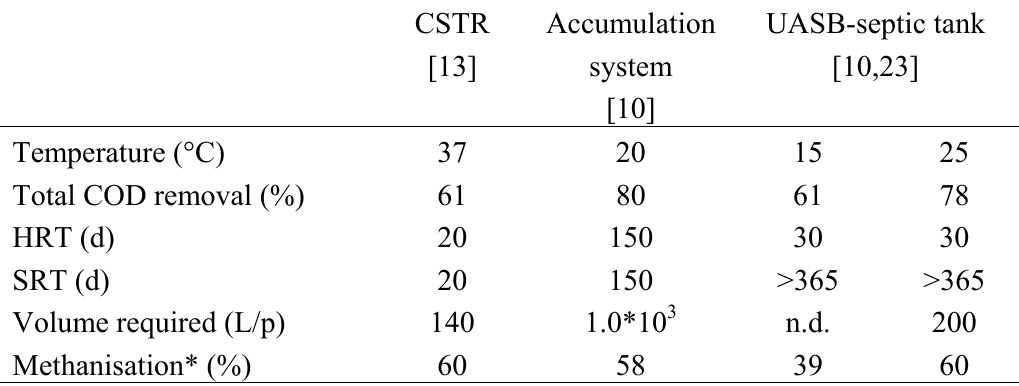
Table 1. Reactors for anaerobic treatment of concentrated black